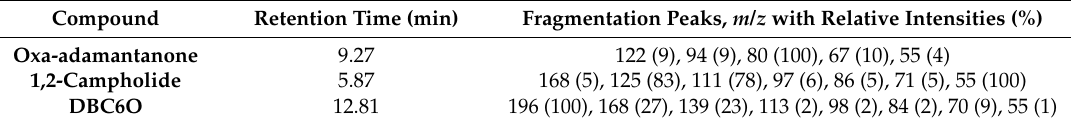
Table 1. Retention times measured on a Supelco SLB-5ms GC column and fragmentation patterns reported from MS spectra with relative intensities in brackets. Generally, the molecular ion was visible for 1,2-campholide and DBC6O, but not for oxa-adamantanone. Oxa-adamantanone and 1,2-campholide showed the characteristic loss of 44 m / z corresponding to loss of CO 2 fragment. In DBC6O two losses of CO (28 m / z ) instead of CO 2 were observed, possibly due to the higher stability of the aliphatic-aromatic structure. Therefore, the formation of the ester group was proved. Additionally, consecutive breakage of the aliphatic ring was visible by loss of CH 2 fragments (14 m / z ). Compound Fragmentation Peaks, m / z with Relative Intensities (%)